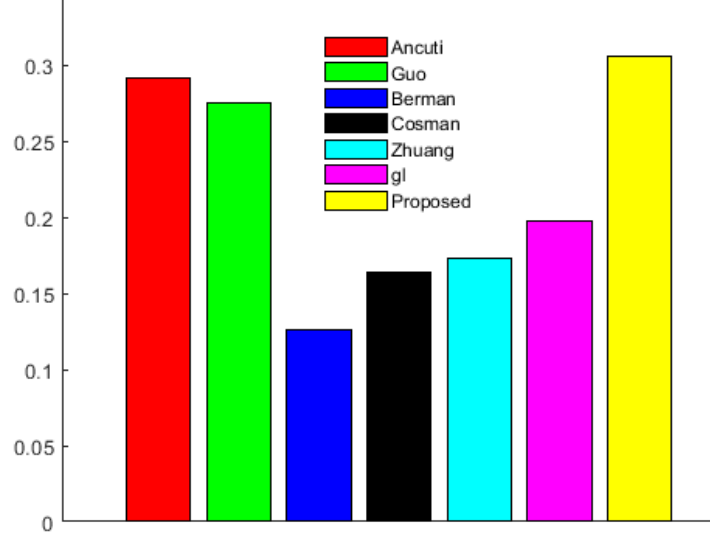
Figure 12. Graphical comparison of UISM.